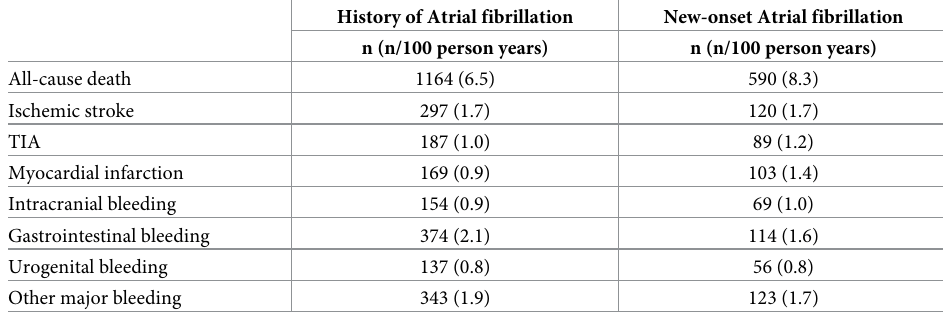
Table 5. The total number and event rate of outcome events during follow